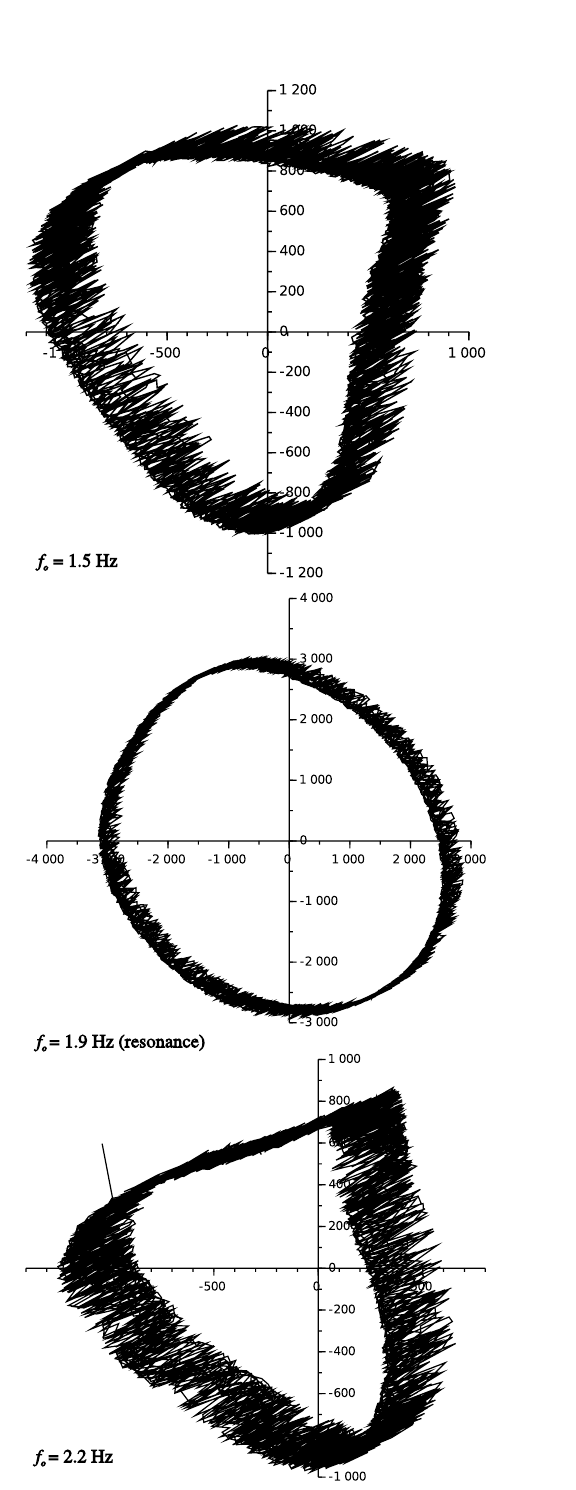
Figure 11. Measured orbit of the ball in water at different excitation frequencies, k o = 0 . 02. The axes are scaled in arbitrary